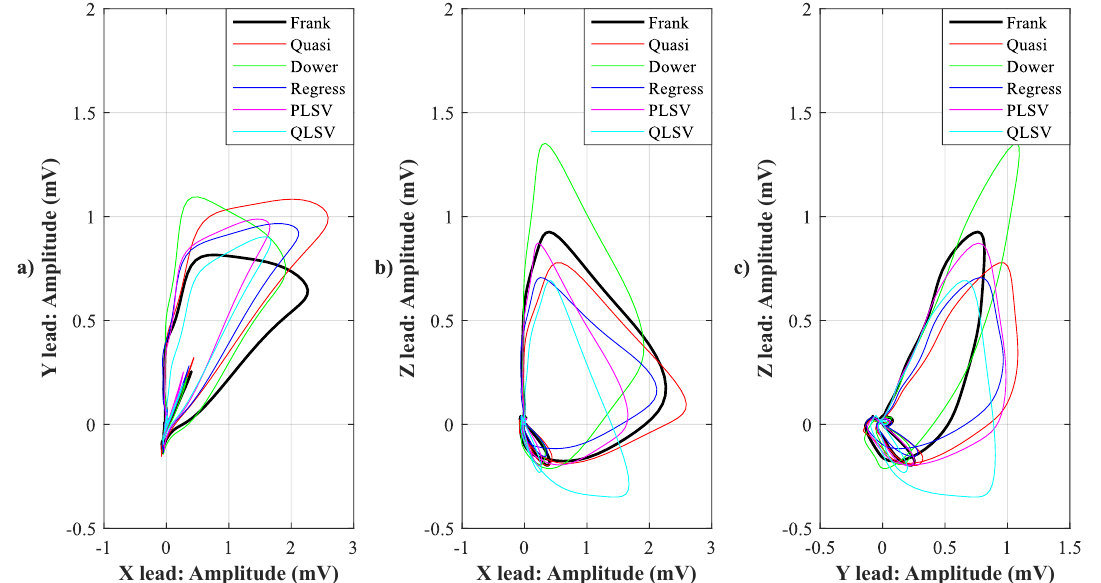
Figure 7. Comparison of transformation methods in 2-D, random patient 1. ( a ) X lead to Y lead, ( b ) X lead to Z lead, and ( c ) Y lead to Z lead.